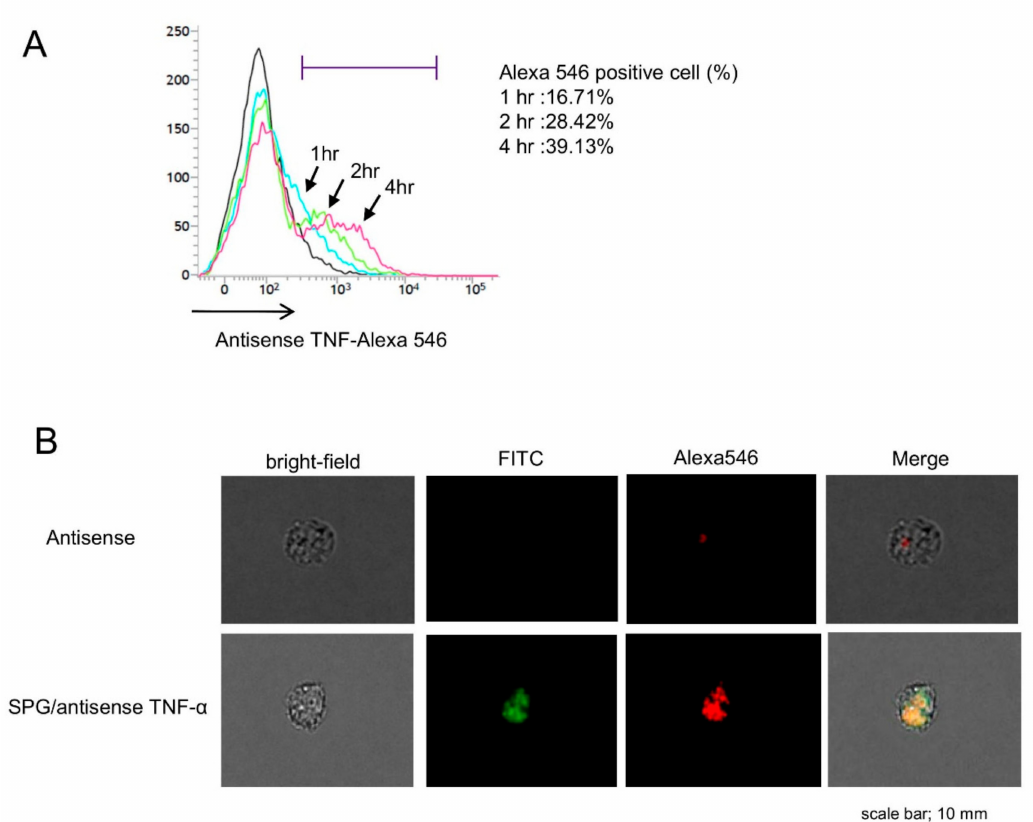
Figure 4. Schizophyllan (SPG)-antisense tumor necrosis factor alpha (TNF- α ) inhibited the production of TNF- α induced by lipopolysaccharide (LPS) in vitro. ( A ) fluorescence activated cell sorter (FACS) analysis revealed that SPG-antisense TNF- α labeling with Alexa Fluor 546 (Alexa 546) was taken up into CD11b + cells in a time-dependent manner. ( B ) Immunofluorescence in CD11b + cells was performed by labeling antisense TNF- α with Alexa546 and the SPG with fluorescein isothiocyanate (FITC) CD11b + cells more e ff ectively took up the SPG-antisense TNF- α compared with antisense TNF- α